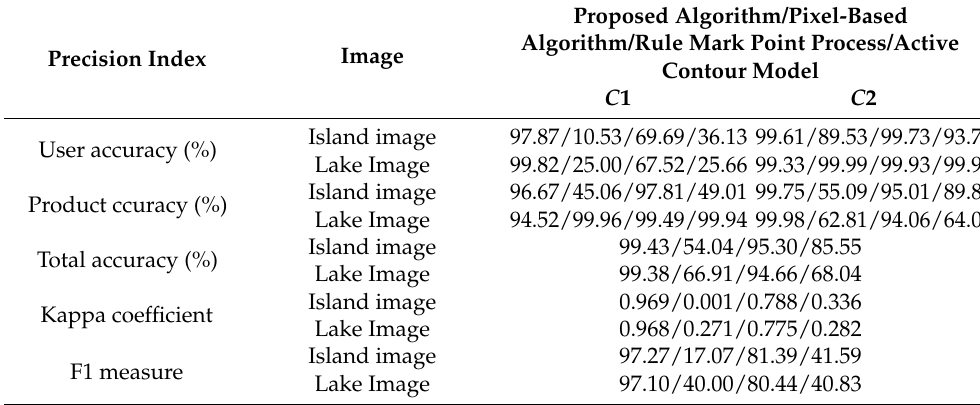
Table 3. Quantitative evaluation of island and lake